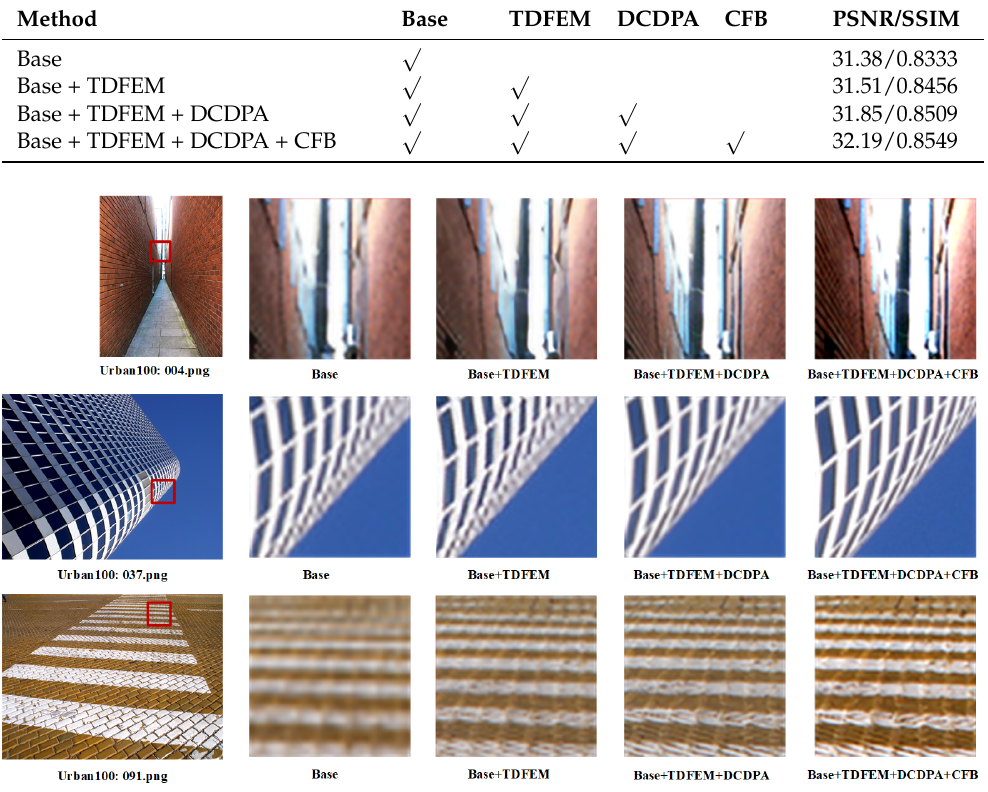
Table 4. Ablation experiment performance.